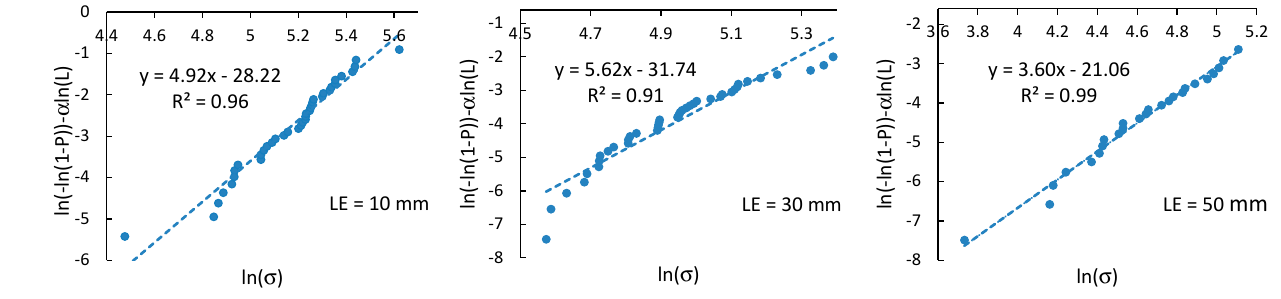
Figure 9. Weibull plots for fiber strength at different gauge lengths.